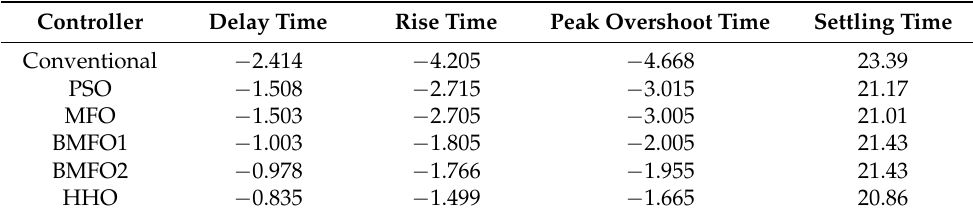
Table 9. Graph analysis of Area1 frequency with various controllers under bilateral contract.